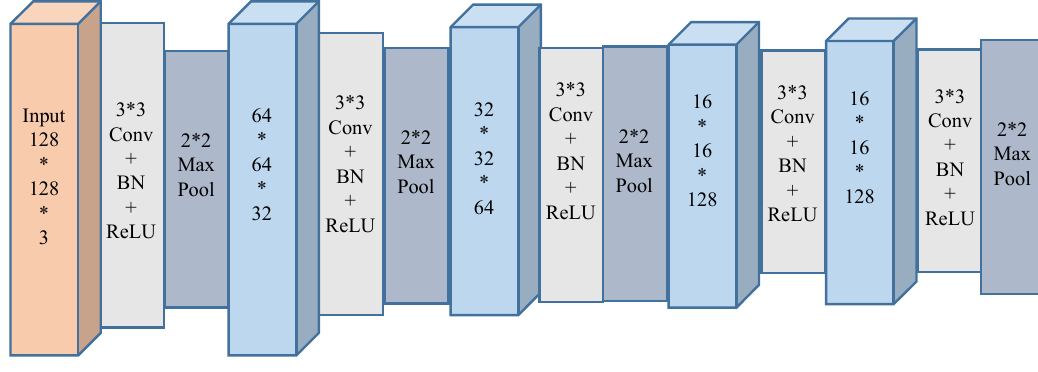
Figure 3. The architecture of the SCNN.